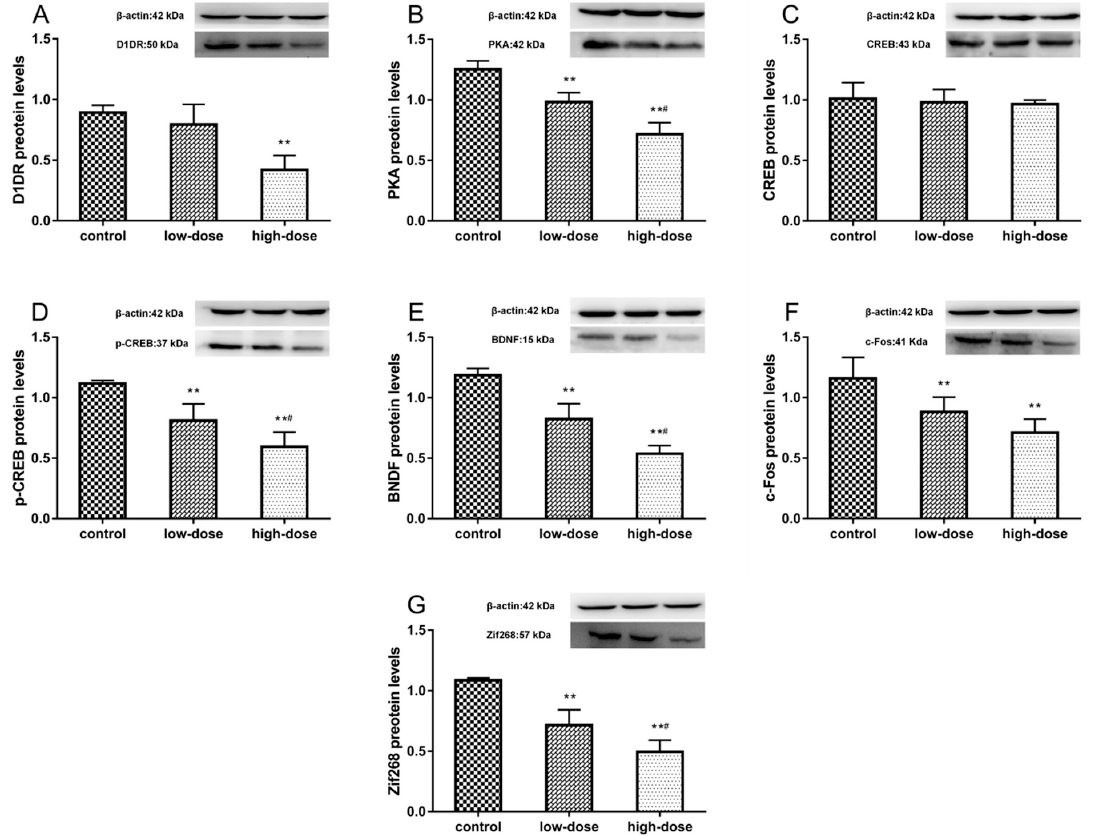
Figure 6. Effects of atrazine (ATR) exposure on protein expression levels in the hippocampus were measured using western blot analysis. ( A ) D1DR, ( B ) PKA, ( C ) CREB, ( D ) p-CREB, ( E ) BDNF, ( F ) c-Fos, and ( G ) Zif268. Expression levels were standardized to β -actin. Each column represents the mean ± S.E.M, six rats per group, ** p < 0.01 vs. the control group. # p < 0.01 between ATR-treated groups.